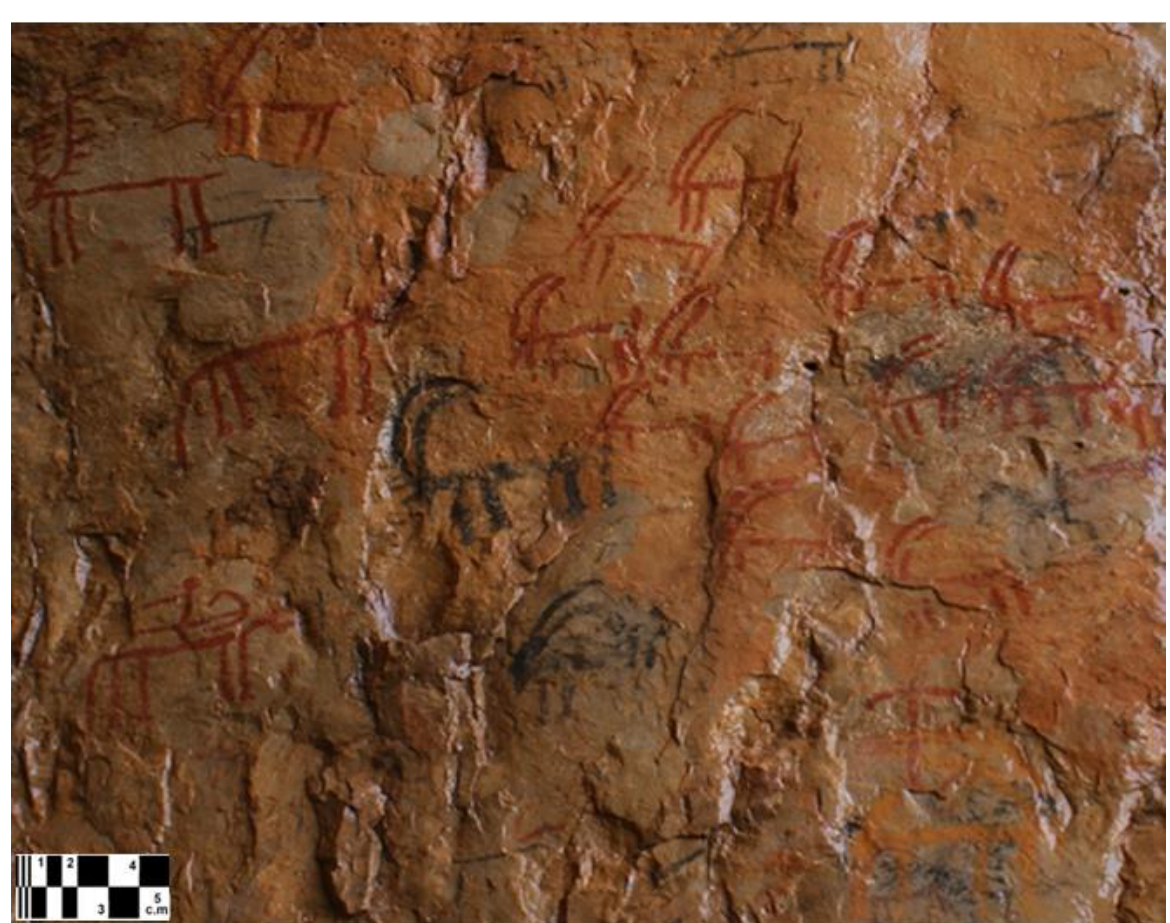
Figure 3. The main group of Pictograms in the Shamsali Rock